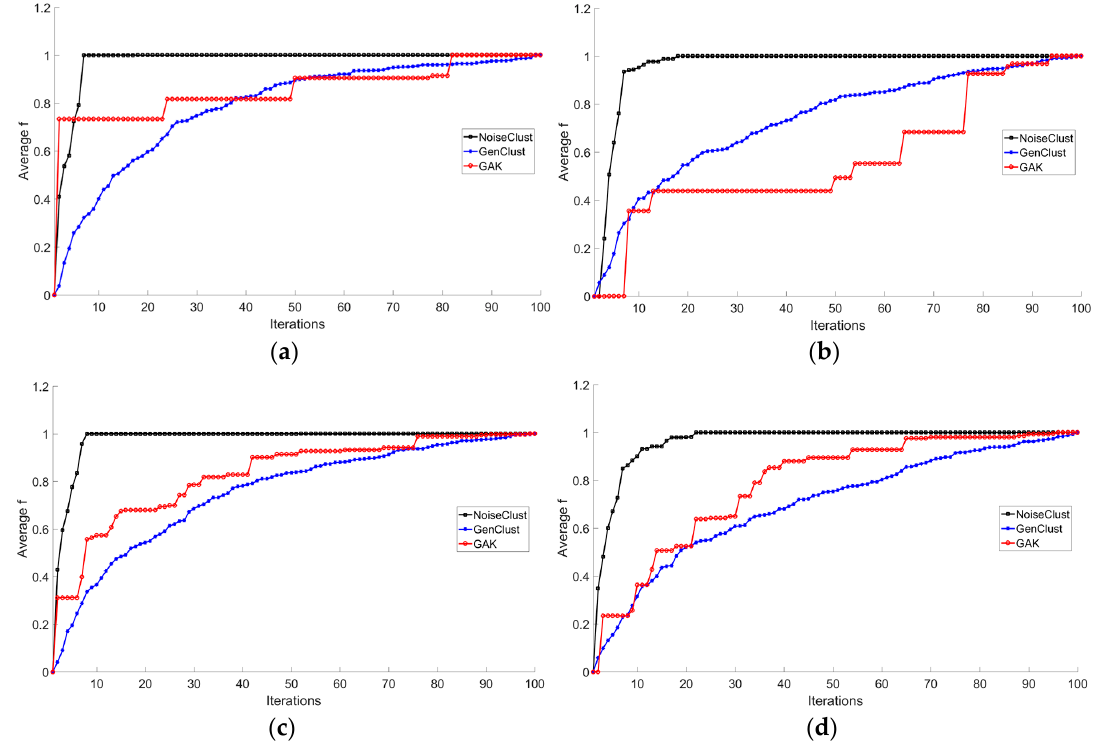
Figure 4. Clustering for the four taxi GPS data sets. The figures plot the Davis–Boudin index ( DBI ) obtained by the GAK, GenClust, and NoiseClust algorithms and averaged over 20 independence experiments: ( a ) Aracaju (Brazil); ( b ) Chongqing (China); ( c ) Roma (Italy); and ( d ) San Francisco (USA).